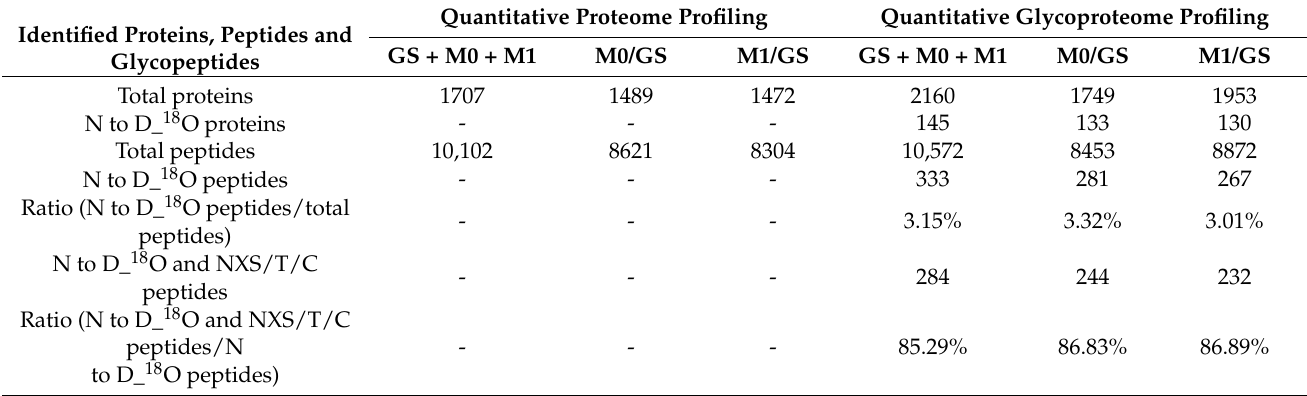
Table 2. Numbers of identified proteins, peptides and glycopeptides in plasma proteome and glycoproteome. Quantitative Proteome Profiling Quantitative Glycoproteome Identified Proteins, Peptides and Glycopeptides